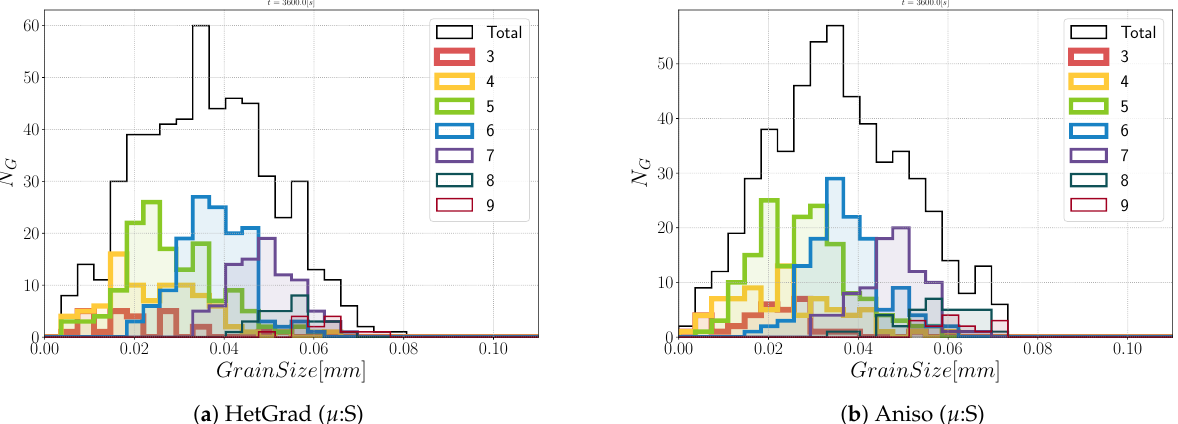
Figure 18. Grain size distribution and contributions from every group of grains of the same coordination number from 3 to 9 at t = 1